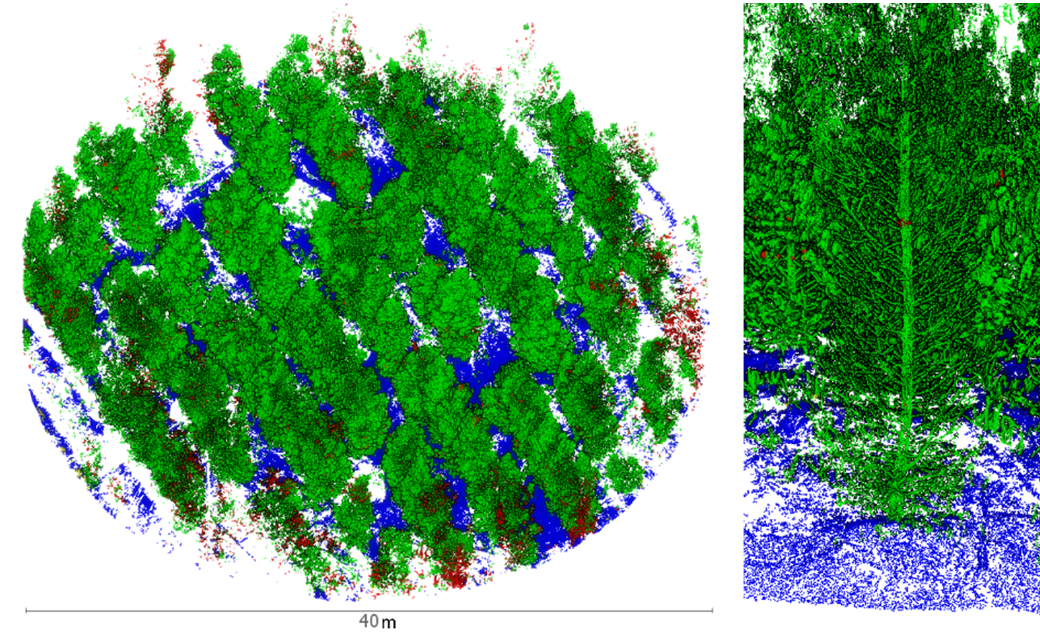
Figure 19. In Plot 38, no trees were detected as the segmentation model failed to segment the young (2 years old) stems. This is likely due to the model not being trained on sufficiently similar tree structures as those in this plot. Future work will see to the inclusion of young trees in the segmentation training dataset to improve the model performance under these forest conditions.